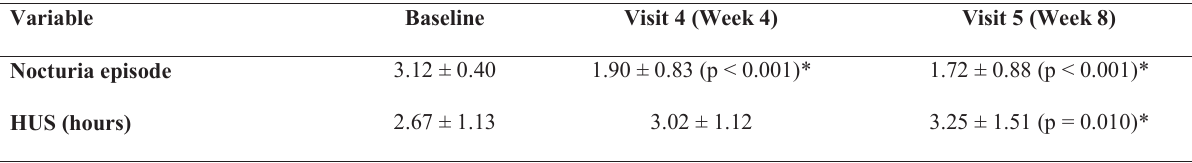
Table 2 - Number of nocturia episodes and hours of undisturbed sleep (HUS) at baseline and after 4 and 8 weeks of treatment.